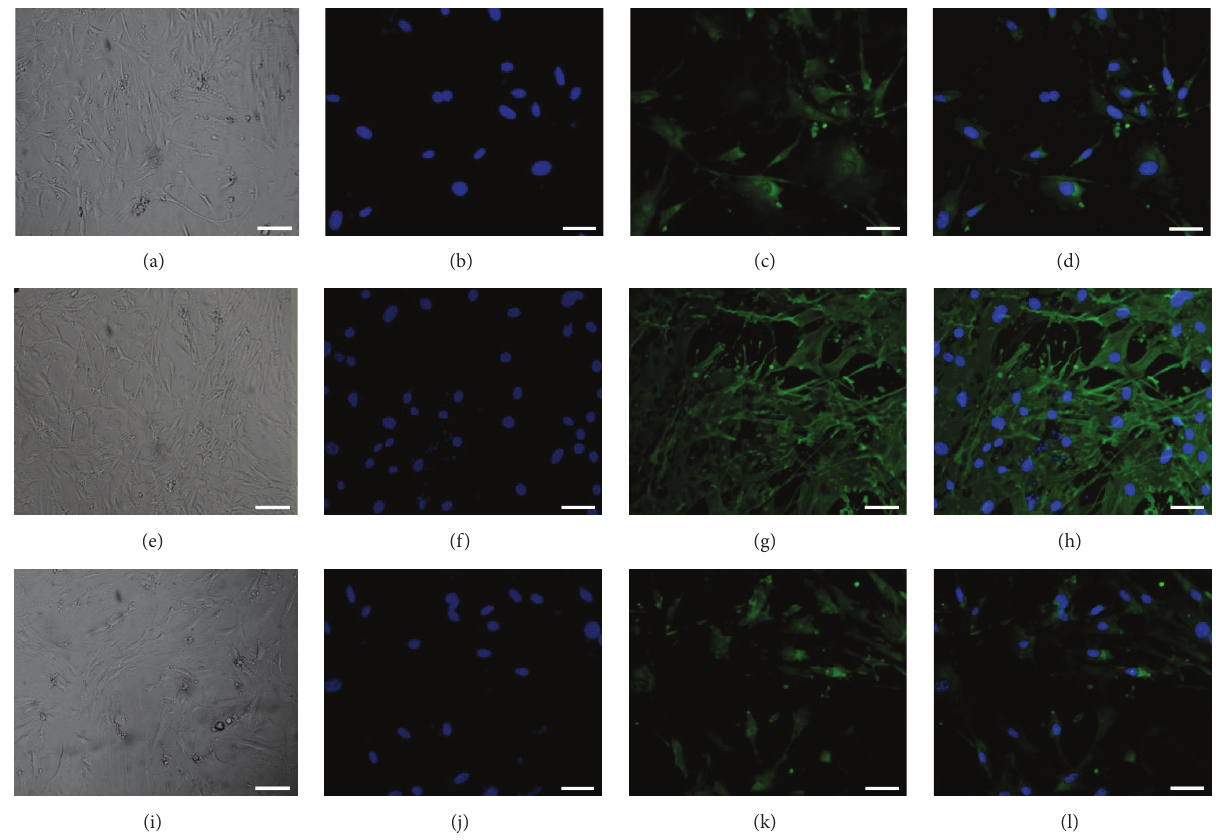
Figure 2: Differentiation potential of Sca-1 + CD31 − cells into cardiomyocyte, smooth muscle, and endothelial cells in vitro using FACS. Cells were stained for specific markers after induction. Immunofluorescence staining (green) of cardiac-specific marker-Cardiac Troponin I (c), smooth muscle marker 𝛼 -Smooth Muscle Actin (g), endothelial cell marker-Von Willebrand Factor (k). (a, e, i) Controls with bright light to show cell morphology after induction. (b, f, j) Nuclei (blue) counterstained with DAPI. (d, h, l) Merged images (b-c), (f-g), and (j-k). Scale bars, 50 𝜇